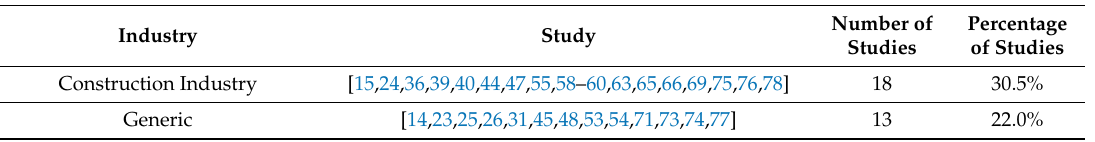
Table 5. Types of industry sectors directly or indirectly suggested as potential recipients for the MoCap solutions developed in the reviewed